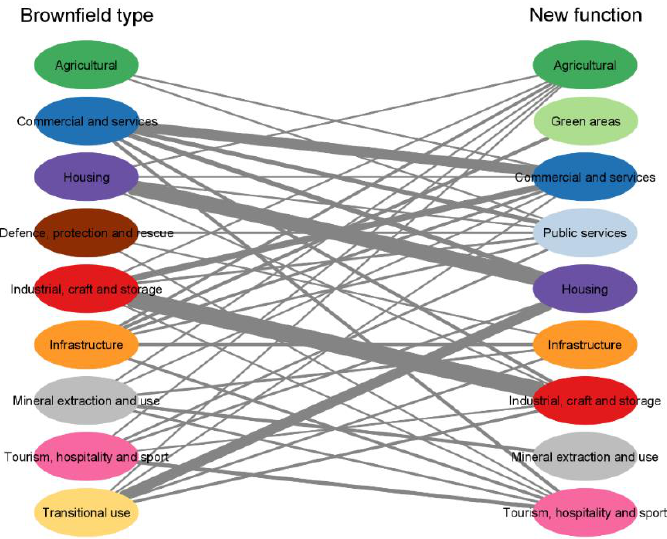
Figure 6. The currents of changes—brownfields regeneration in Slovenia (2017–2022). Line thickness indicating the number of changes. Based on [24,25]. Prepared by the authors.